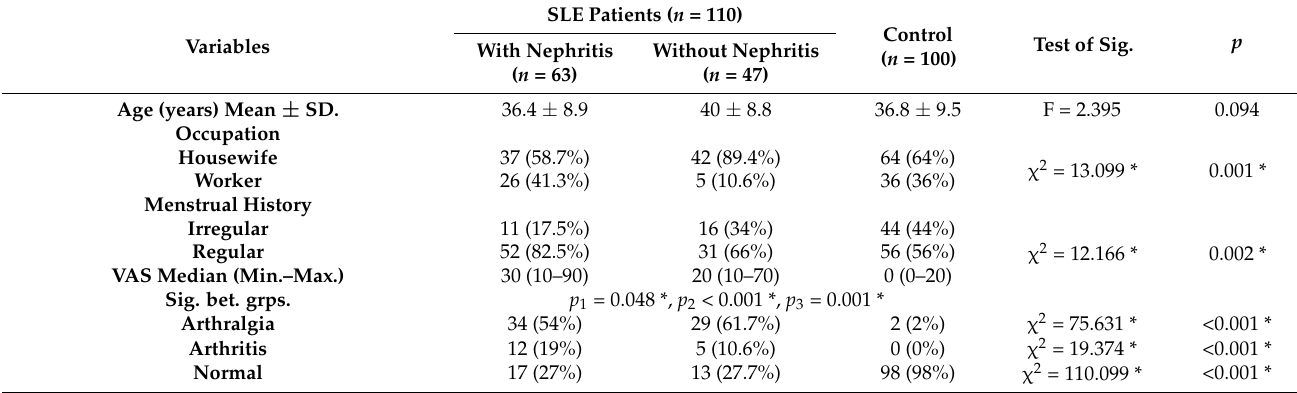
Table 3. Comparisons between the three studied groups according to different parameters.